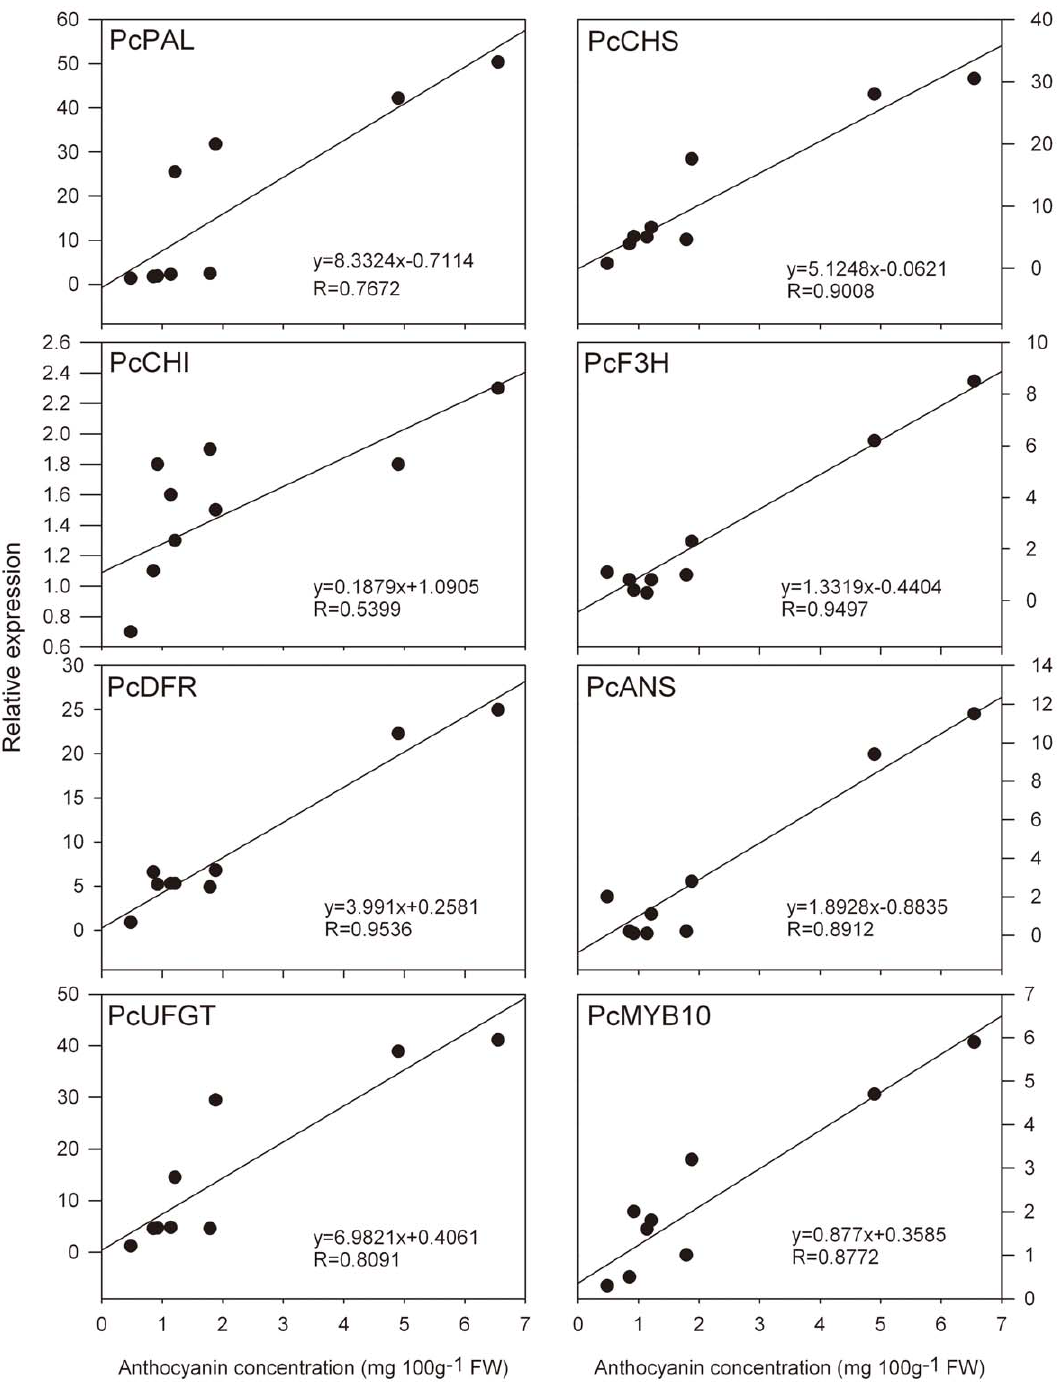
Figure 5. Correlation between anthocyanin concentration and the expression profile of anthocyanin biosynthetic genes in ‘Wujiuxiang’ pears exposed to LT and RT.